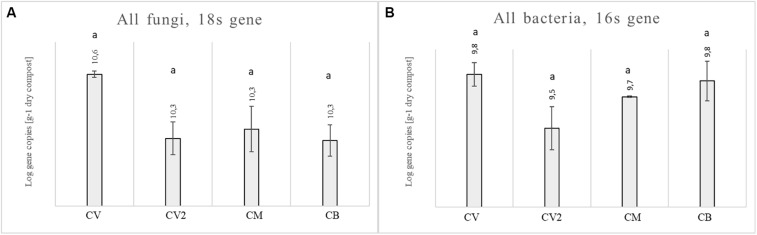
Abundance of the fungal 18S rRNA gene (A) and bacterial 16S rRNA gene (B) for four composts: CV, CM, CB, and CV2. Different letters indicate statistical differences between the four composts, as obtained with the ANOVA test and Tukey’s post hoc test.